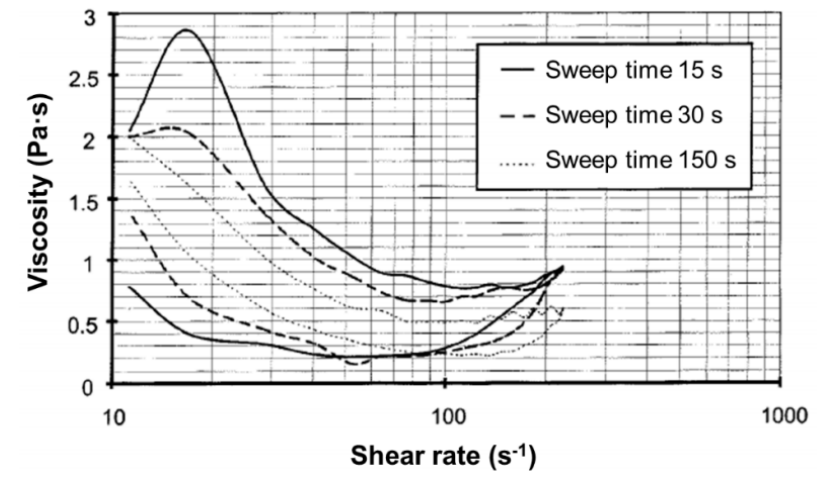
Figure 11. Hysteresis experiments at different sweep times ( T = 198 ◦ C, Fs = 0.45)